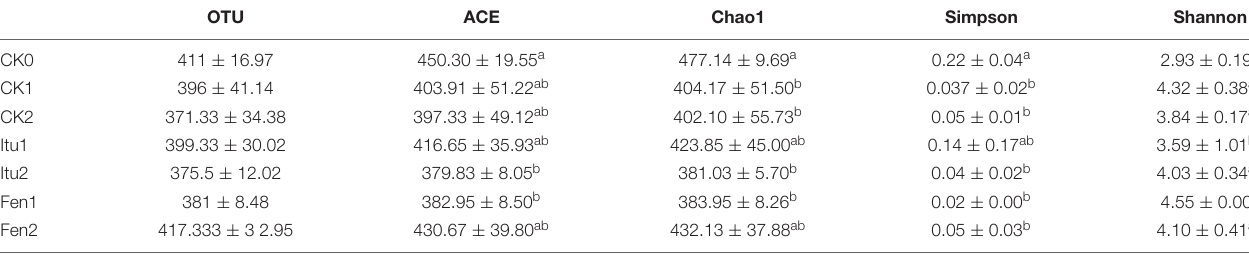
TABLE 2 | OTU abundance and diversity index of fungal communities in all soil samples.